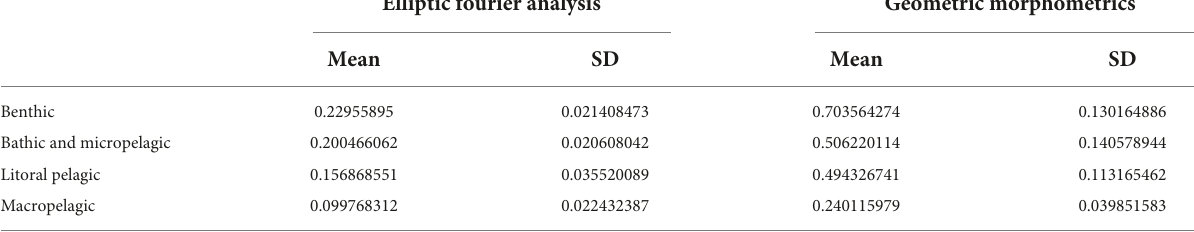
TABLE 3 Euclidean distances between Amazichthys trinajsticae gen. et sp. nov. and shark ecomorphotypes calculated after principal component analysis from Elliptical Fourier analyses on the whole body and geometrics morphometrics on the caudal fin. Elliptic fourier analysis Geometric